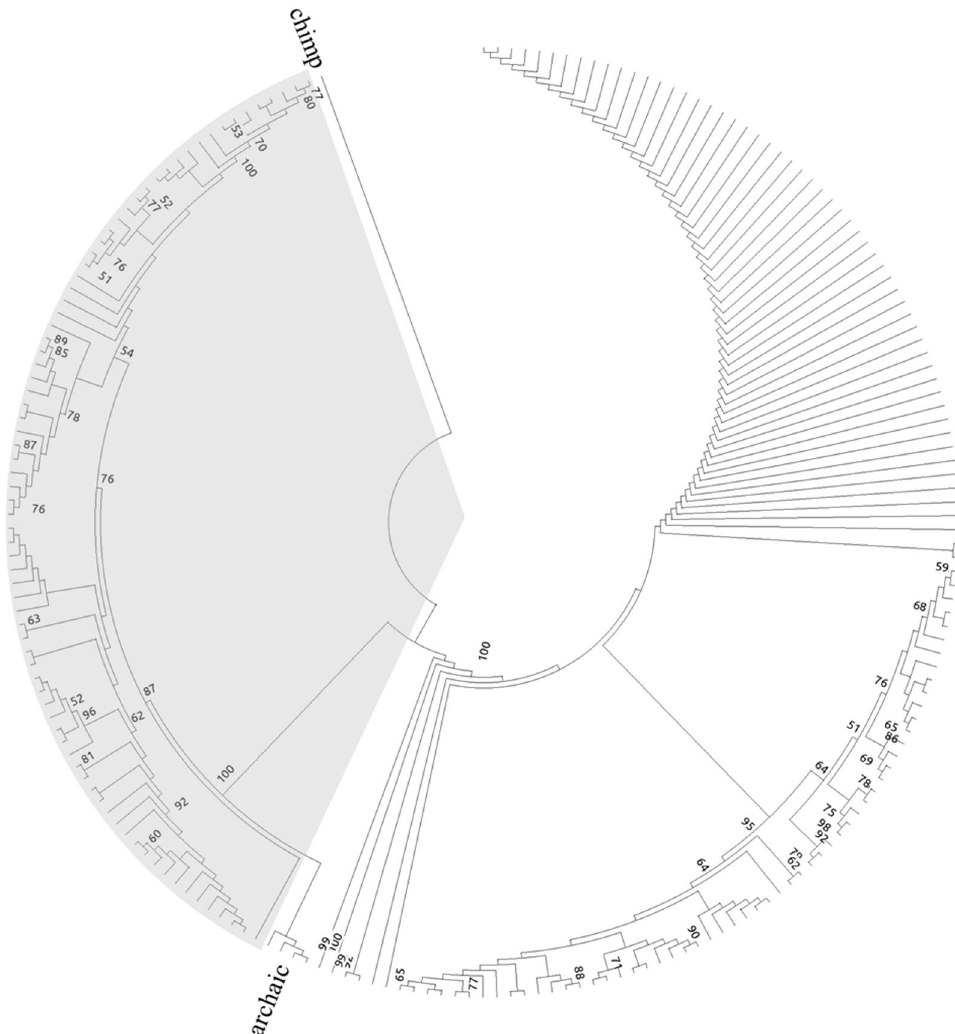
Figure 2. Phylogeny of CEU haplotypes. Chimpanzee sequence is used as an outgroup and labeled as chimp. Archaic clade includes four individuals, from left to right, Denisovan, Altai, Chagyrskaya and Vindija. CEU haplotypes are not labeled. The haplotype 2 lineages are marked by gray background. Arab numbers indicate bootstrap support and only the ones > 50 are